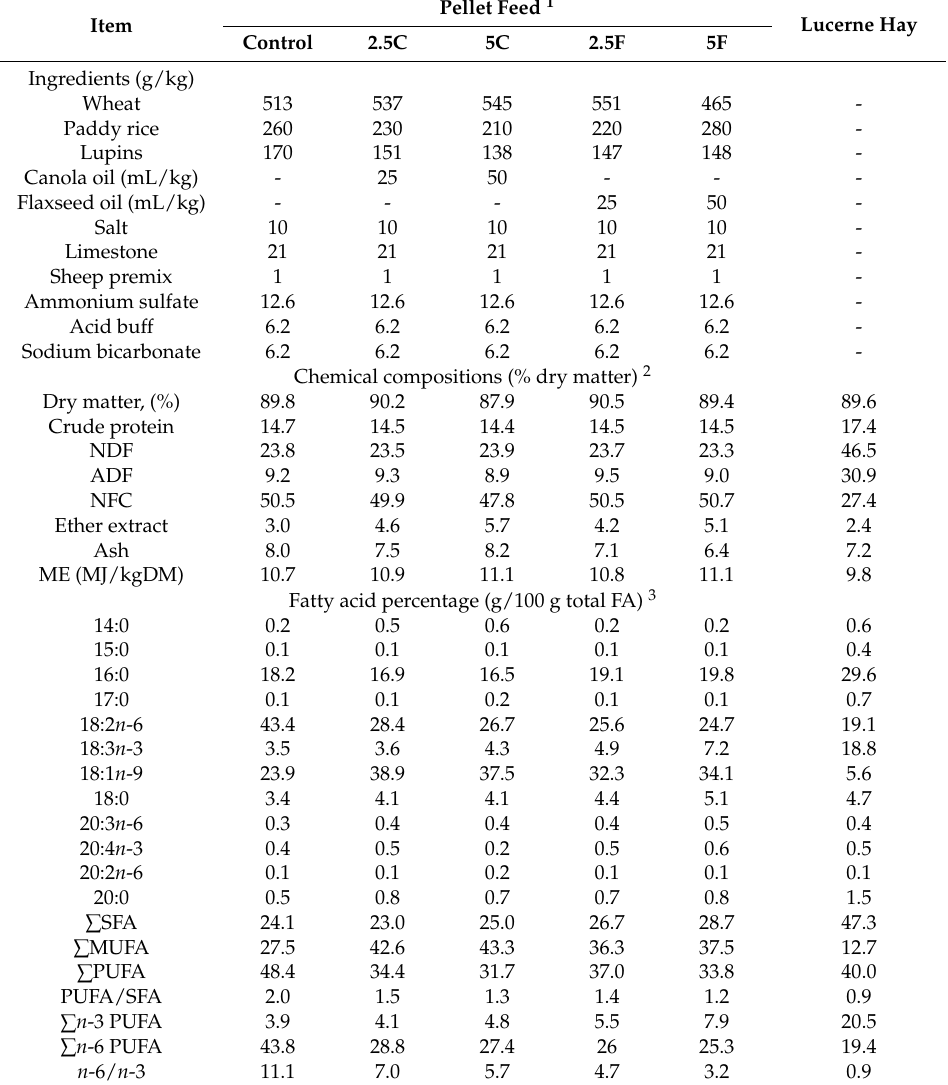
Table 1. Ingredients, chemical compositions and fatty acid percentage of feeds.